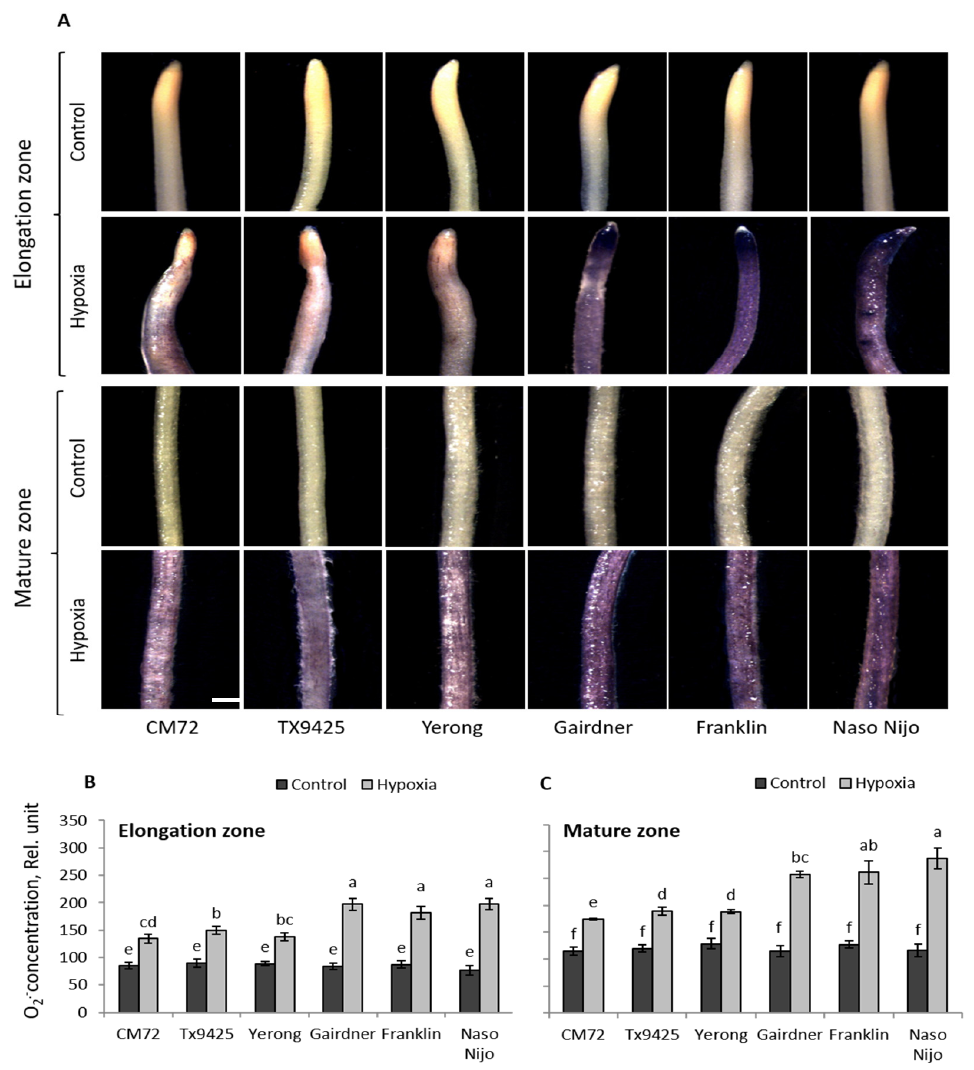
Figure 1. ( A ) Histochemical detection of superoxide (O 2 •− ) in the elongation and mature zone in the roots of six barley cultivars differing in waterlogging tolerance. ( B ) Relative quantification of the O 2 •− concentration in the elongation and ( C ) the mature root of barley. Image J software (NIH, Bethesda, MD, USA) was used to calculate relative (O 2 •− ) concentration by targeting the fluorescence integrated density. Data are the mean ± SE; n = 150–250; 20–30 cells analysed for at least 6–8 individual seedlings (biological replicates). The scale bar = 1 mm. Different lowercase letters indicate the significant difference at p ≤ 0.05 according to Duncan’s multiple range tests.